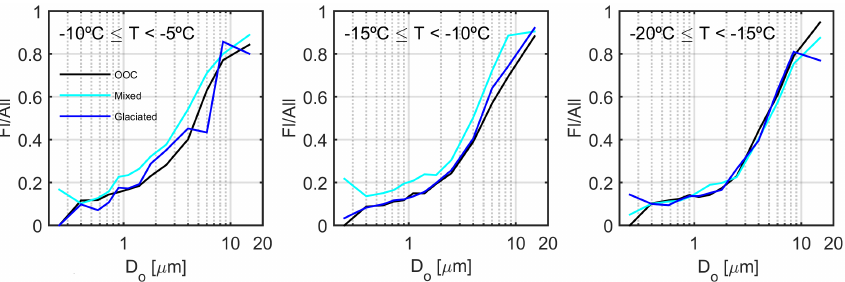
Figure 11. Size-dependent fluorescent aerosol fractions for (left to right panels) out-of-cloud (black), mixed-phase (cyan), and glaciated conditions (blue) over the three different temperature regimes studied.